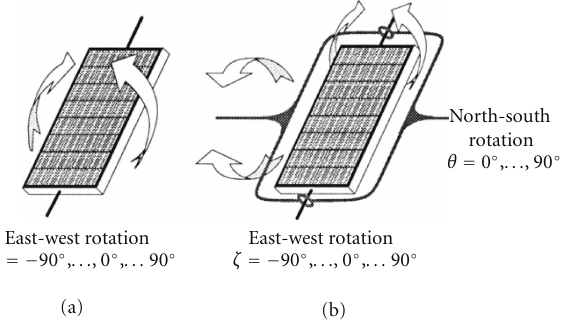
Figure 1: One (a) and two-axis (b) tracking configurations where the PV modules rotate about the axes (inclination and azimuth) by a controllable gear.